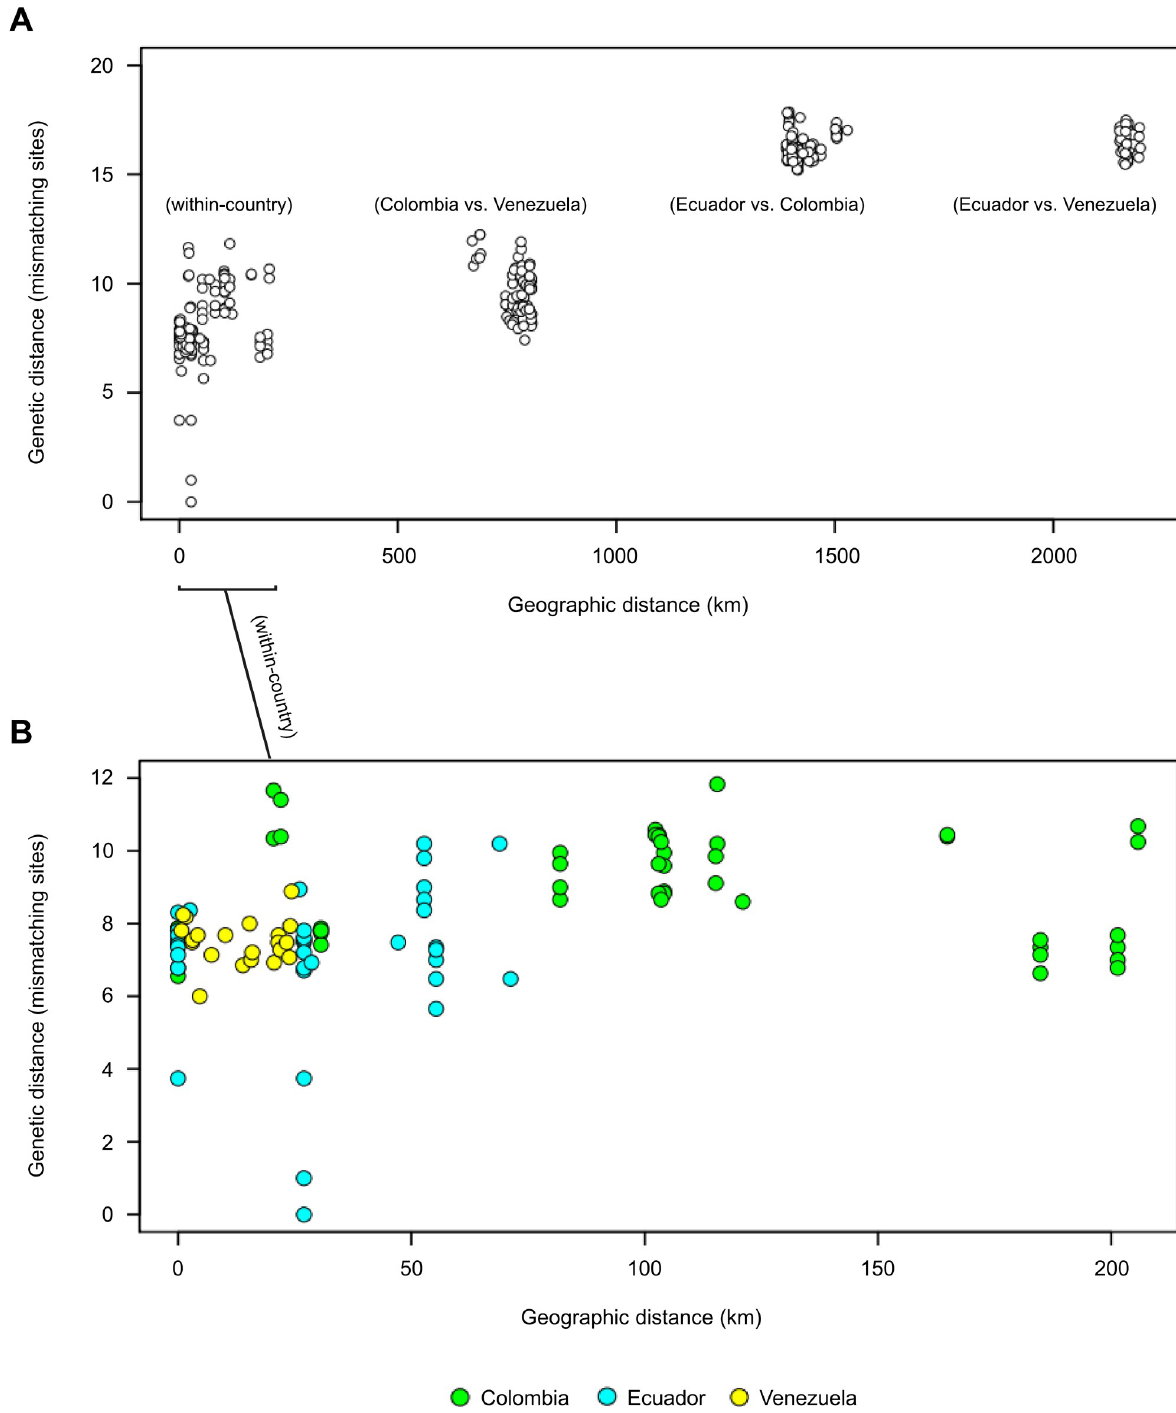
Fig 5. Spatio-genetic correlation among T . cruzi I samples. A) Each circle represents geographic and genetic distances between two TcI samples. Positive correlation in the multi-country dataset (Mantel’s r = 0.89, p = 0.001) is driven by divergence between samples from Ecuador and Colombia/Venezuela (see two clusters at top right). B) Nevertheless, this relationship remains significant for within-country comparisons at < 250 km (Mantel’s r = 0.30, p = 0.009) and < 150 km (Mantel’s r = 0.48, p = 0.002). Green, cyan and yellow fill colors represent comparisons within Colombia, Ecuador and Venezuela, respectively. Each of the above Mantel tests remains significant when sample pairs with genetic distances < 2 are removed. Only variant sites with � 10% missing genotypes (n = 285) are used in analysis. Only the first replicate is used for samples represented by multiple